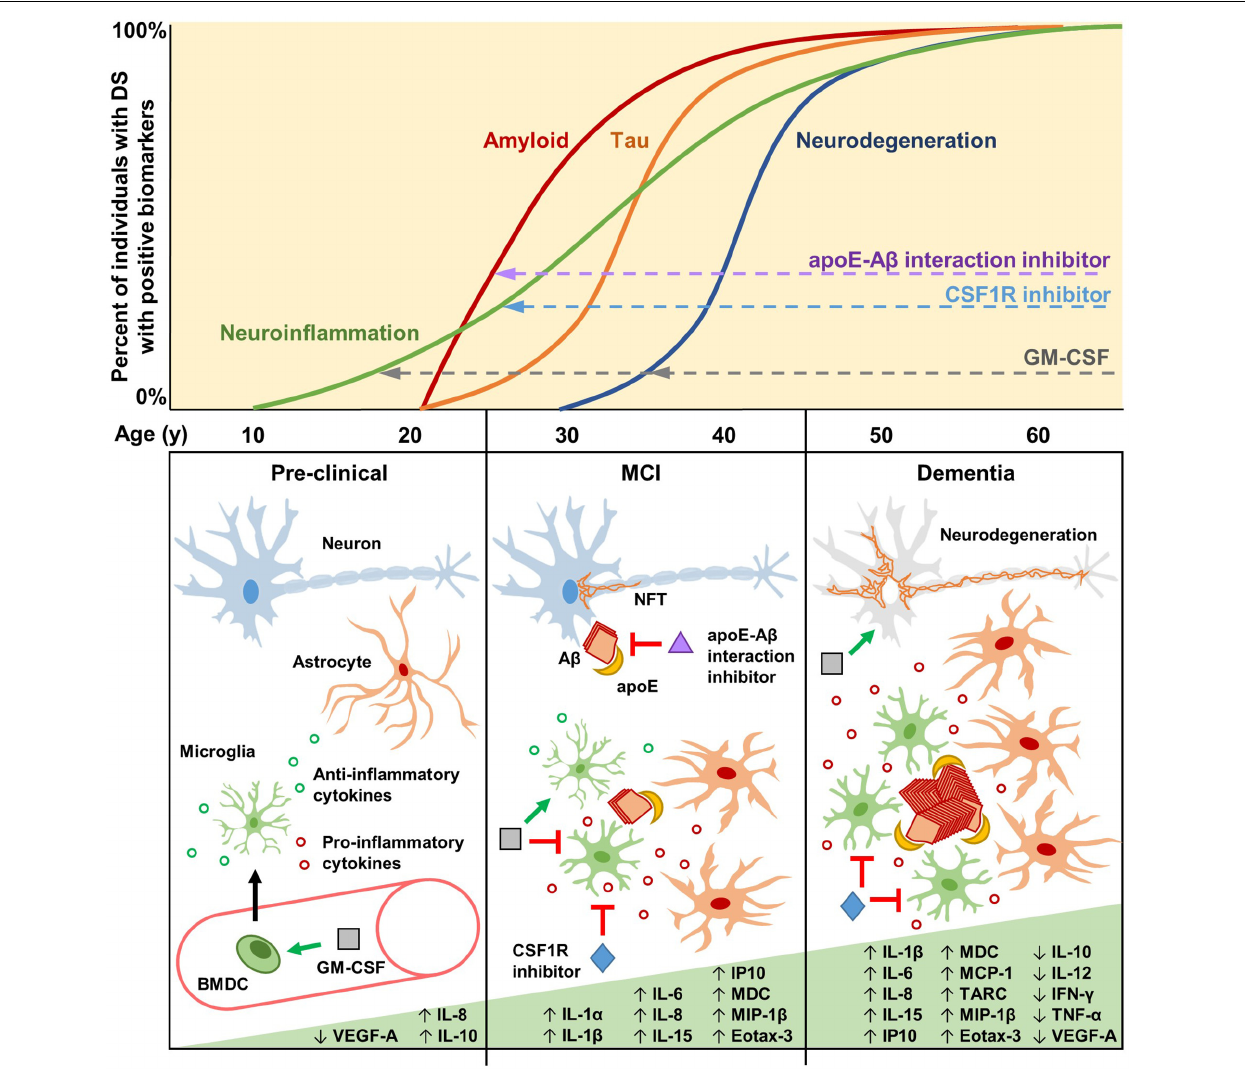
FIGURE 1 | Biomarkers, cytokines, and potential therapeutic mechanisms for neuroinflammation in Down syndrome (DS) and Alzheimer’s disease (AD). Biomarkers of neuroinflammation, amyloid and tau pathology, and neurodegeneration increase over the lifetimes of the vast majority of individuals with DS.